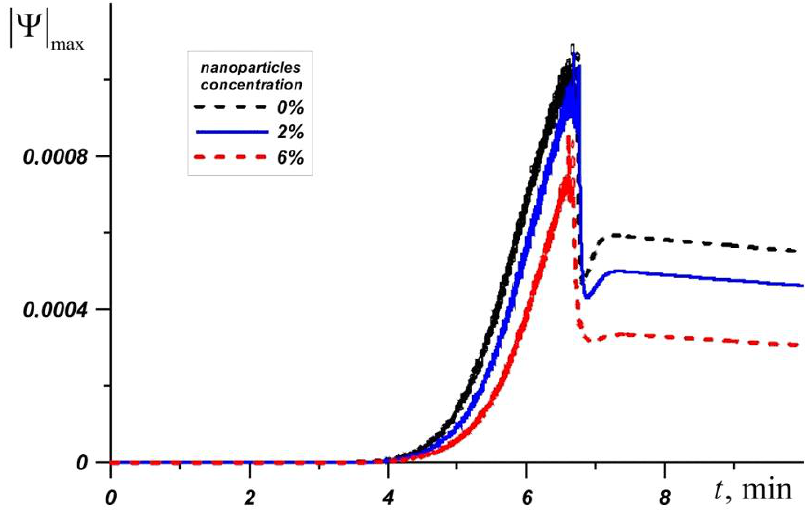
Figure 7. Maximum value of the stream function for RT-80 at different nanoparticle concentrations.